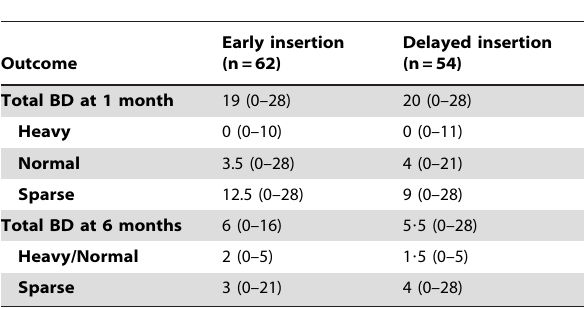
Table 3. The number of days of bleeding pattern following Early versus Delayed IUC insertion evaluated at 1 and 6 months